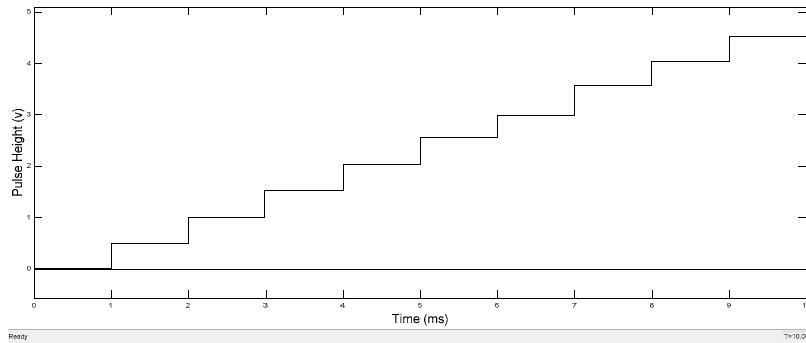
Figure 6. Detector equivalent outputs without pile-up.